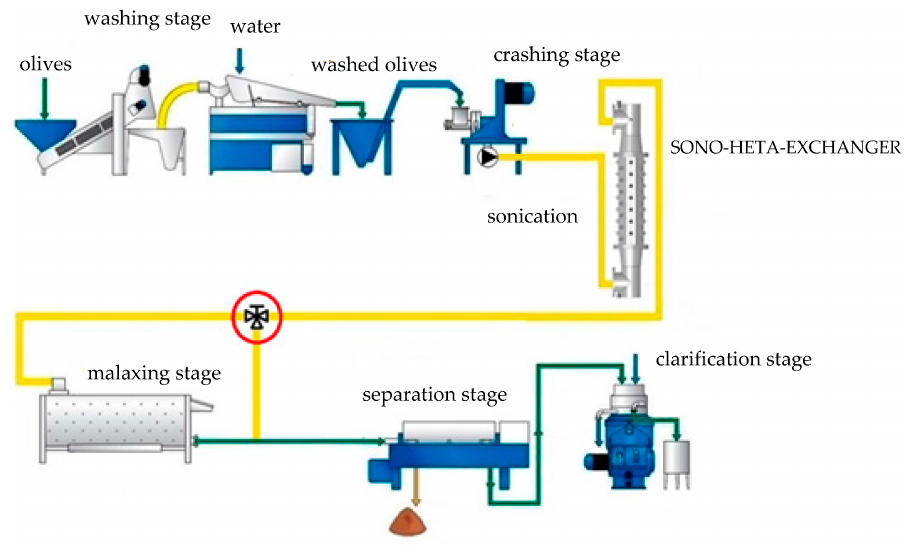
Figure 3. Olive oil processing line.